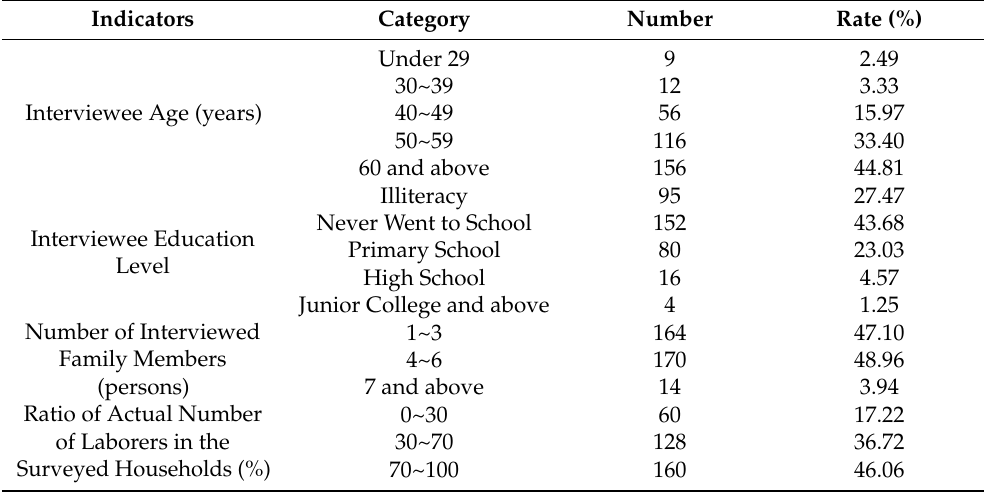
Table 2. Characteristic distribution of farmer